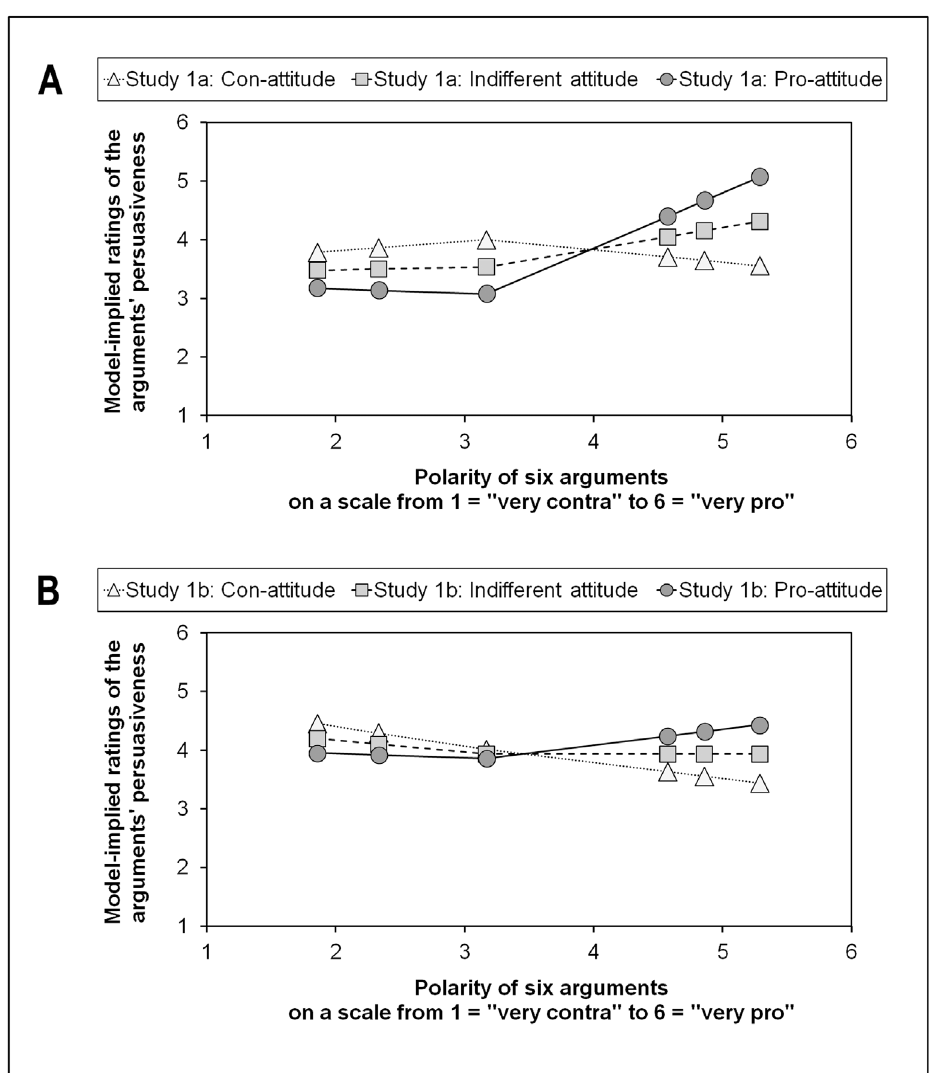
Fig 4. Piecewise growth curves: MOOCs. (A) Study 1a. (B) Study